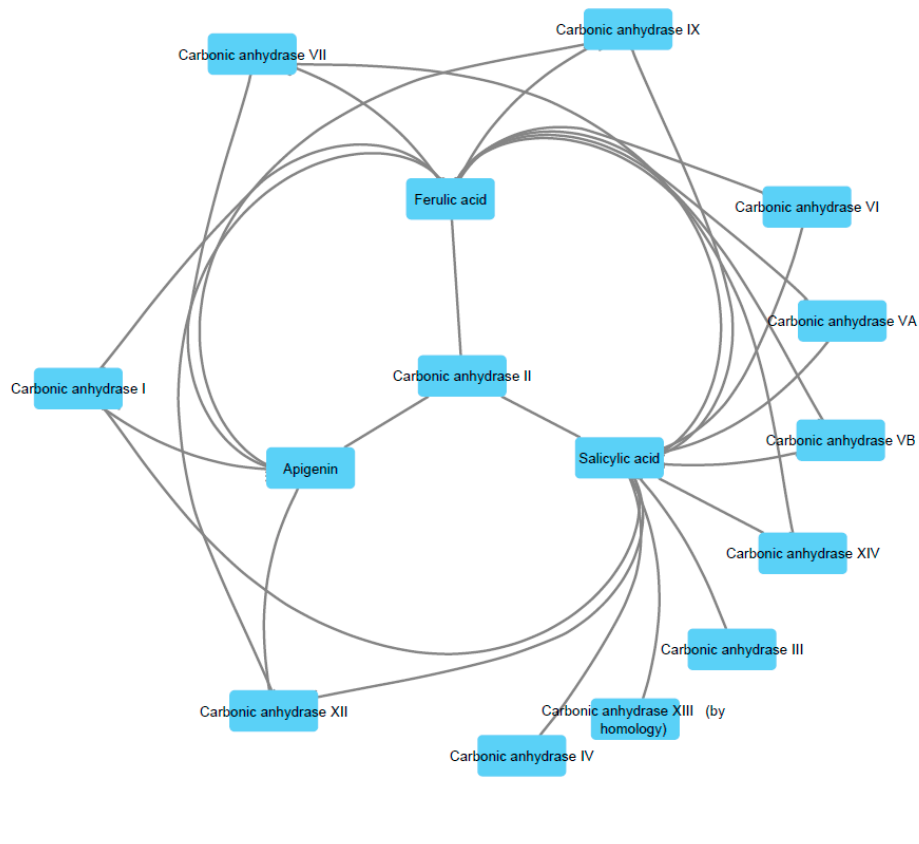
Figure 4. Pharmacological profile of phenolic compounds identified through ultra-high performance liquid chromatography coupled with hybrid quadrupole-Orbitrap high resolution mass spectrometry (UHPLC-HRMS) analysis in methanol, ethylacetate and dichloromethane extracts, and in water infusion of A. aspera dried aerial parts. Molecular target and pharmacokinetic profile were predicted through SwissTargetPrediction (http://www.swisstargetprediction.ch/) and SwissADME (http://www.swissadme.ch/index.php) platforms, respectively. Accordingly, the Venn diagram ( A ) was conducted based on high gastrointestinal absorption, blood barrier permeation and high probability to interact with a selected molecular target (carbonic anhydrase II). Finally, based on Venn diagram, components-targets analysis ( B ) was carried out through Cytoscape software (3.7.2 version) on apigenin, ferulic acid and salicylic acid. Extended results are included as supplementary material (Supplementary Material Bioinformatic Analysis). A . Venn diagram related to selected phenolic compounds; B . Components-targets analysis. Single predicted carbonic anhydrase targets.